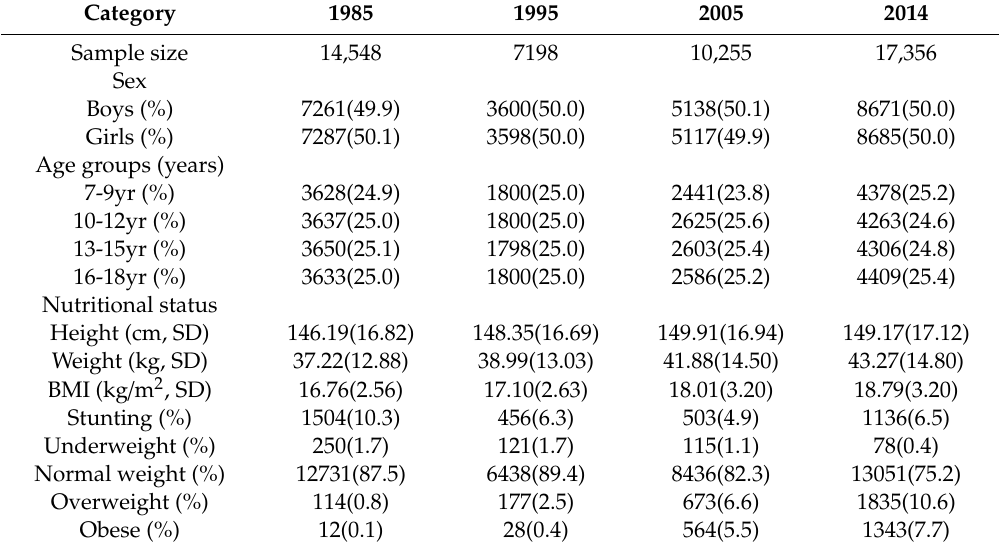
Table 1. Sample distribution and nutrition status among children and adolescents aged 7–18 in Xinjiang, 1985 to 2014.